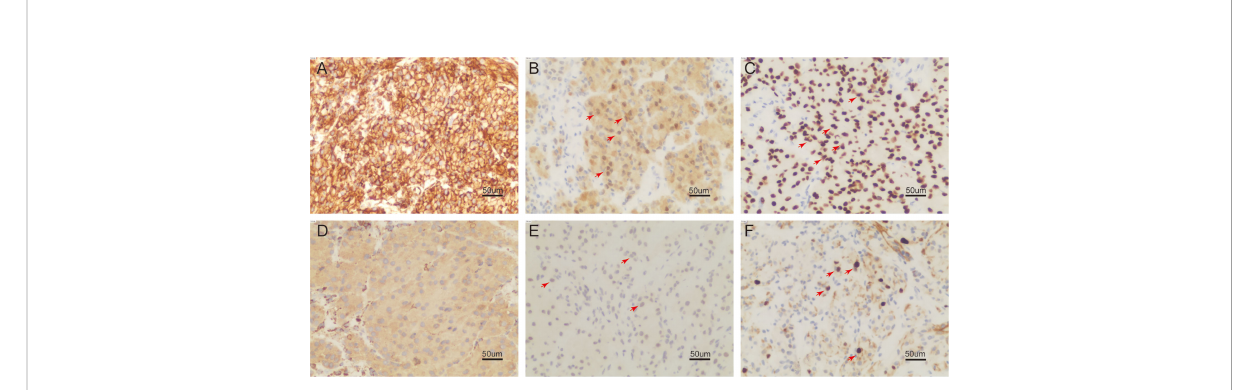
FIGURE 3 On immunohistochemistry examination (200 ×), the tumor cell is reactive to vimentin (A) , S-100 (B) , SOX-10 (C) , KP-1 (D) , PHH3 showed positive mitotic cells (E) , Ki-67 reacted more than 8% (F) (positive region in (B, C, E, F) marked with red